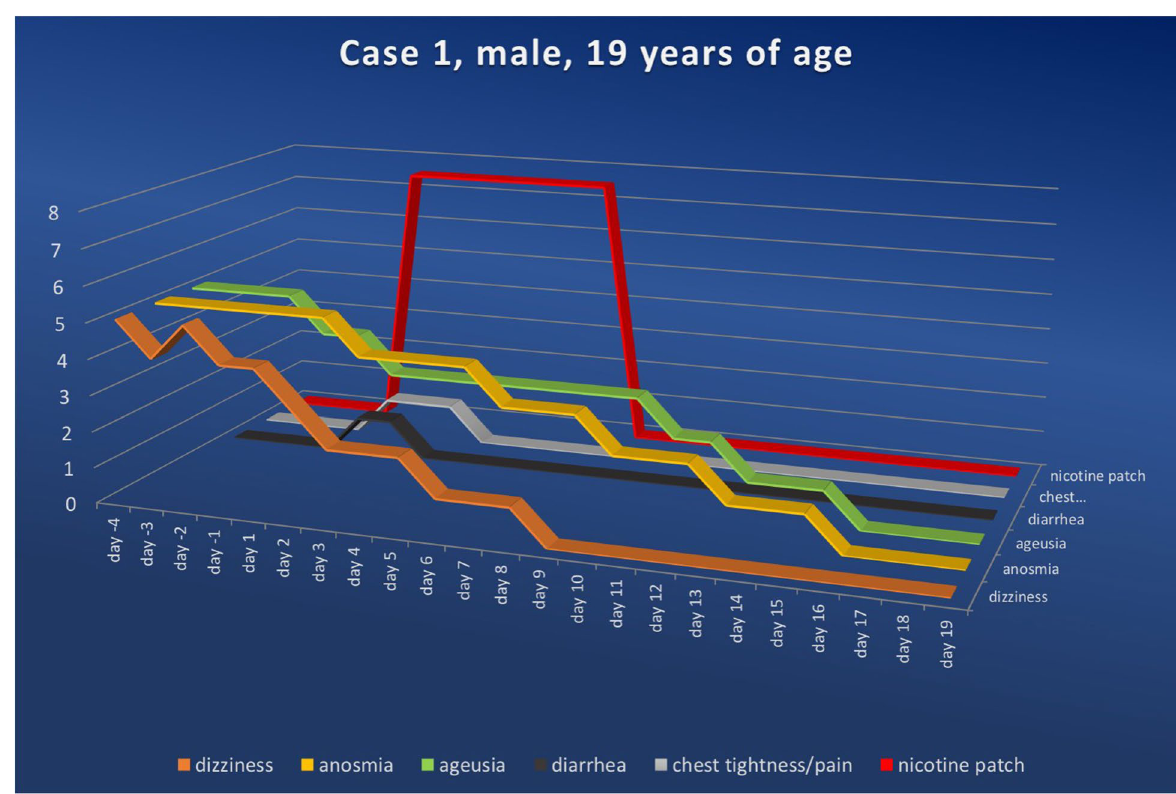
Fig. 3 Symptom score for case 1 ranging from the fourth day prior to and to the twenty-sixth day after nicotine administration (fourth symptom-free day). Upon nicotine treatment, the symptom scores in all categories fell continuously. The numerical value in the ordinate shows the value of the symptom score, while the nicotine dosage for the amount delivered per 24 h is shown in